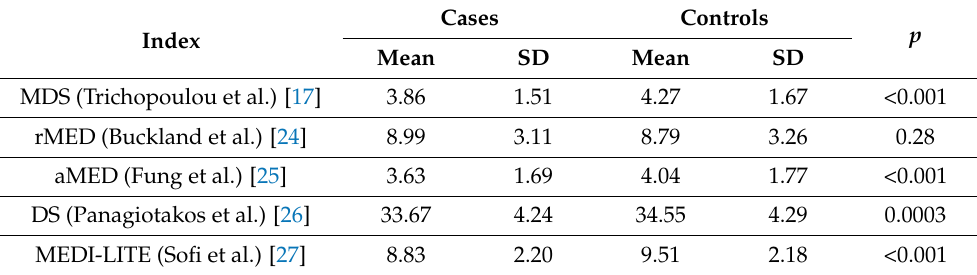
Table 4. Average MD adherence score by group for each index